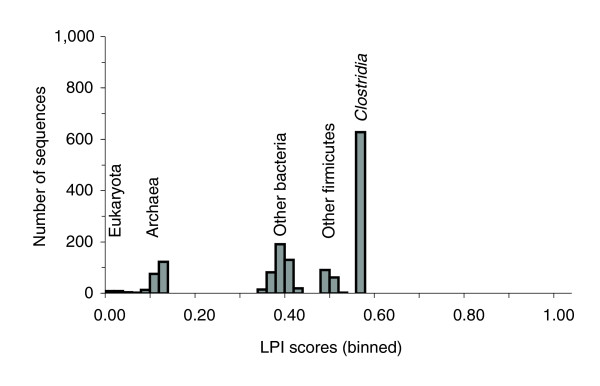
LPI score distribution histogram for T. maritima. Filter threshold setting was zero.